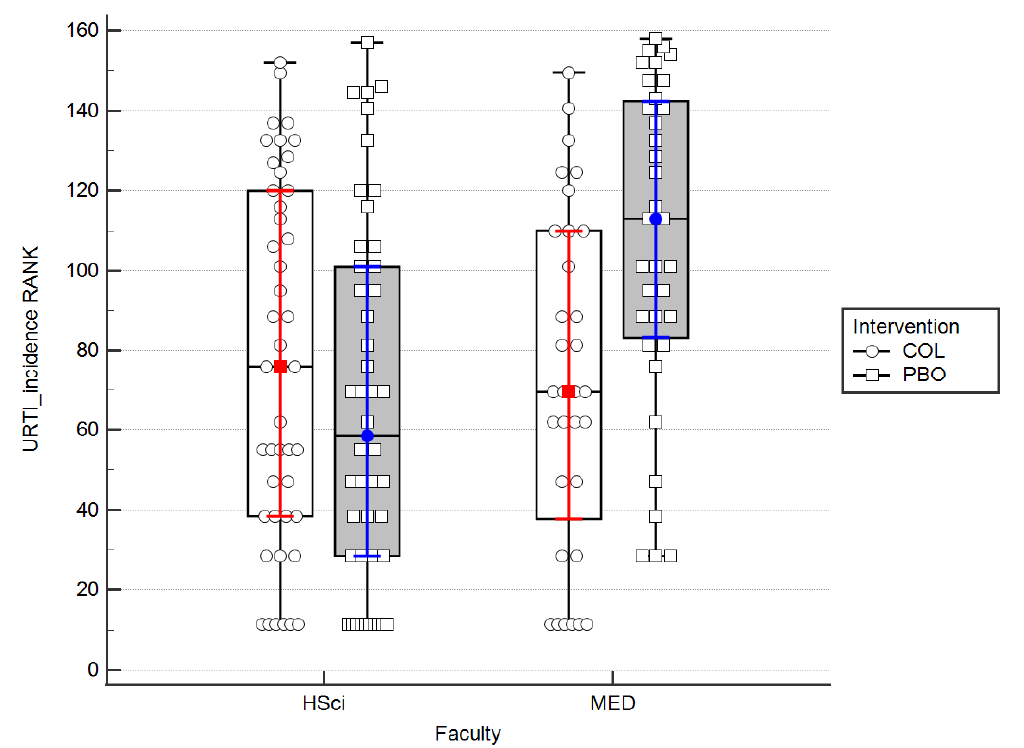
Figure 2. A bar plot on the efficacy of COL in reducing of the URTIs symptoms frequency by the course of studies. Medians and IQRs are shown. Dots and squares depict individual cases; data are ranked. MED—medicine; HSci—health Science.